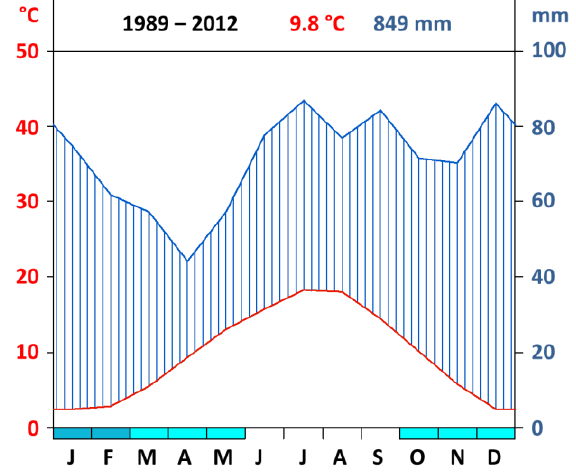
Figure 2. Climate graph (Walter & Lieth 1967) for the meteorological stations Rastede (precipitation, mm) and Oldenburg (temperature, °C), located at distances of 4 km and 11 km, respectively, from the study area. The right-hand vertical axis indicates precipitation in mm per calendar month. On the horizontal axis, dark blue panels indicate months when the occurrence of frost is certain, and light blue panels those when it is possible. Data provided by the German Meteorological Service DWD (Deutscher Wetterdienst).